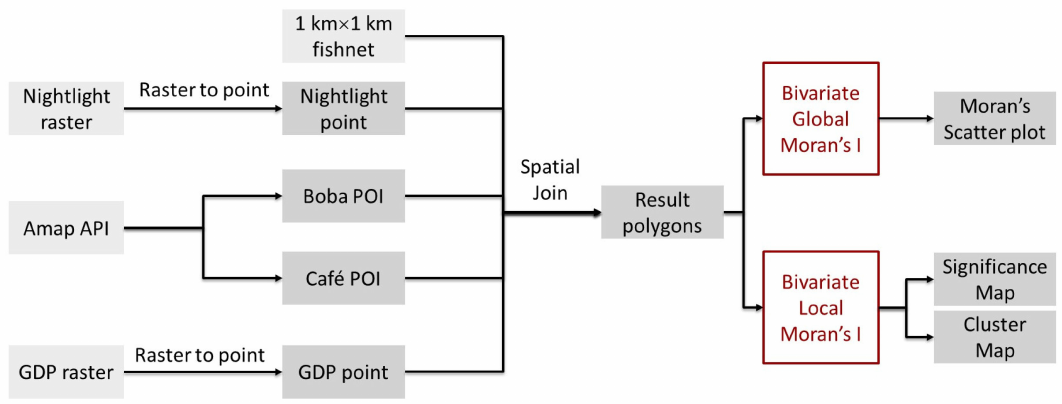
Figure 3. The workflow of bivariate Moran’s I analysis for four cities in